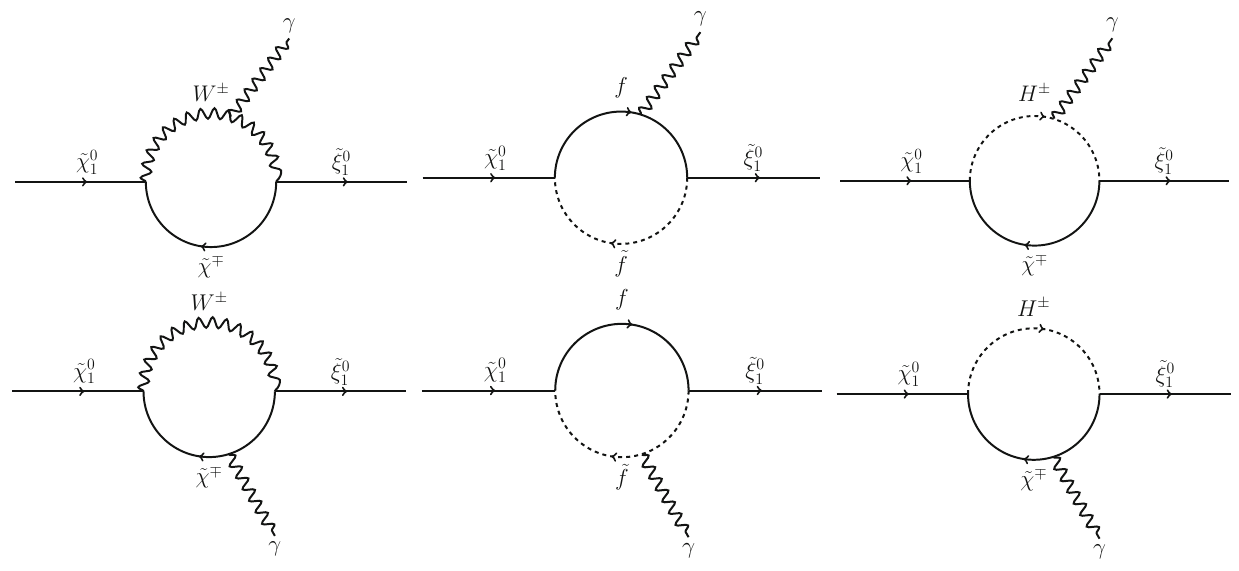
Fig. 1 Loop diagrams contributing to the neutralino radiative decay ˜ χ 0